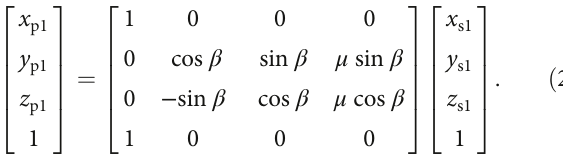
The pitch plane of the oblique rack P